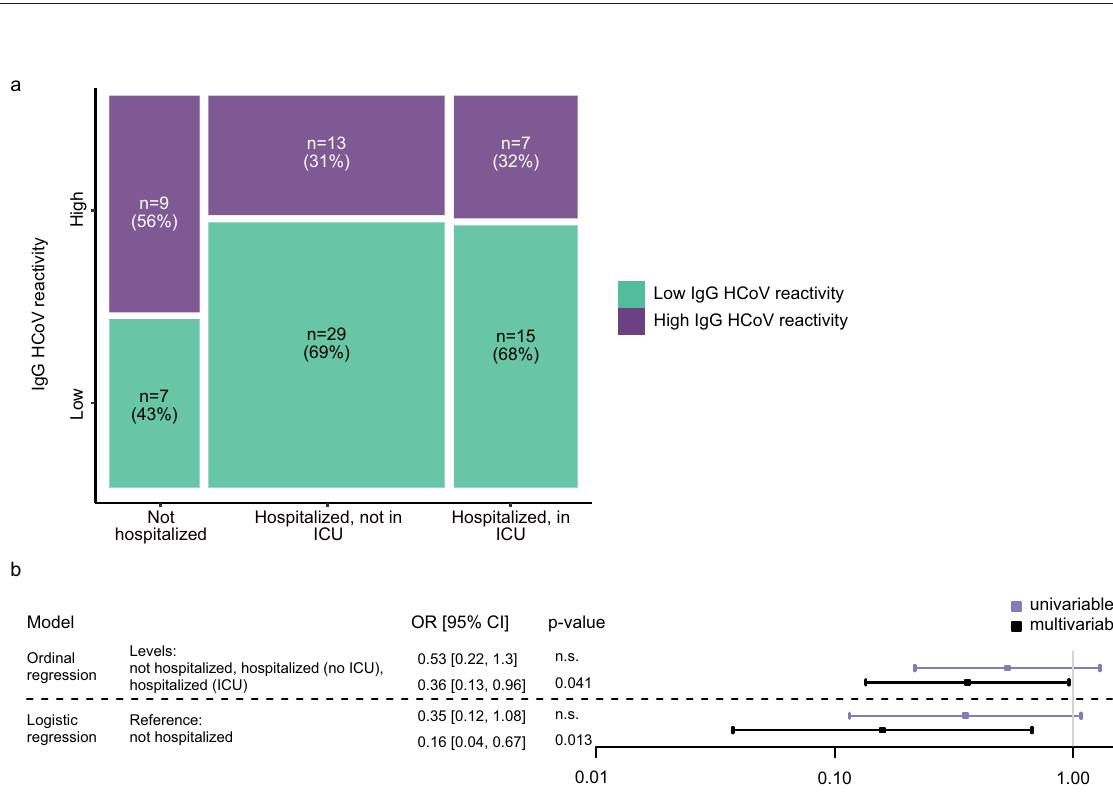
Fig. 8 Impact of HCoV immunity on COVID-19 severity. a Association of hospitalization status (not hospitalized ( N = 16); hospitalized not in ICU ( N = 42); hospitalized in ICU ( N = 22)) and high or low IgG HCoV reactivity. Rectangle sizes correspond to the proportion of included patients. b In fl uence of HCoV reactivity (low/high) on the hospitalization status in a subset of N = 80 patients, as estimated with odds ratios, in an ordinal regression (with levels = not hospitalized ( N = 16); hospitalized not in ICU ( N = 42); hospitalized in ICU ( N = 22)) and a logistic regression (reference = not hospitalized ( N = 16); versus all hospitalized ( N = 64)). Data is presented as parameter estimation and its 95% con fi dence interval. Level of signi fi cance of the parameter is obtained with a two-sided t -test ( p -value is displayed if <0.05, otherwise indicated as